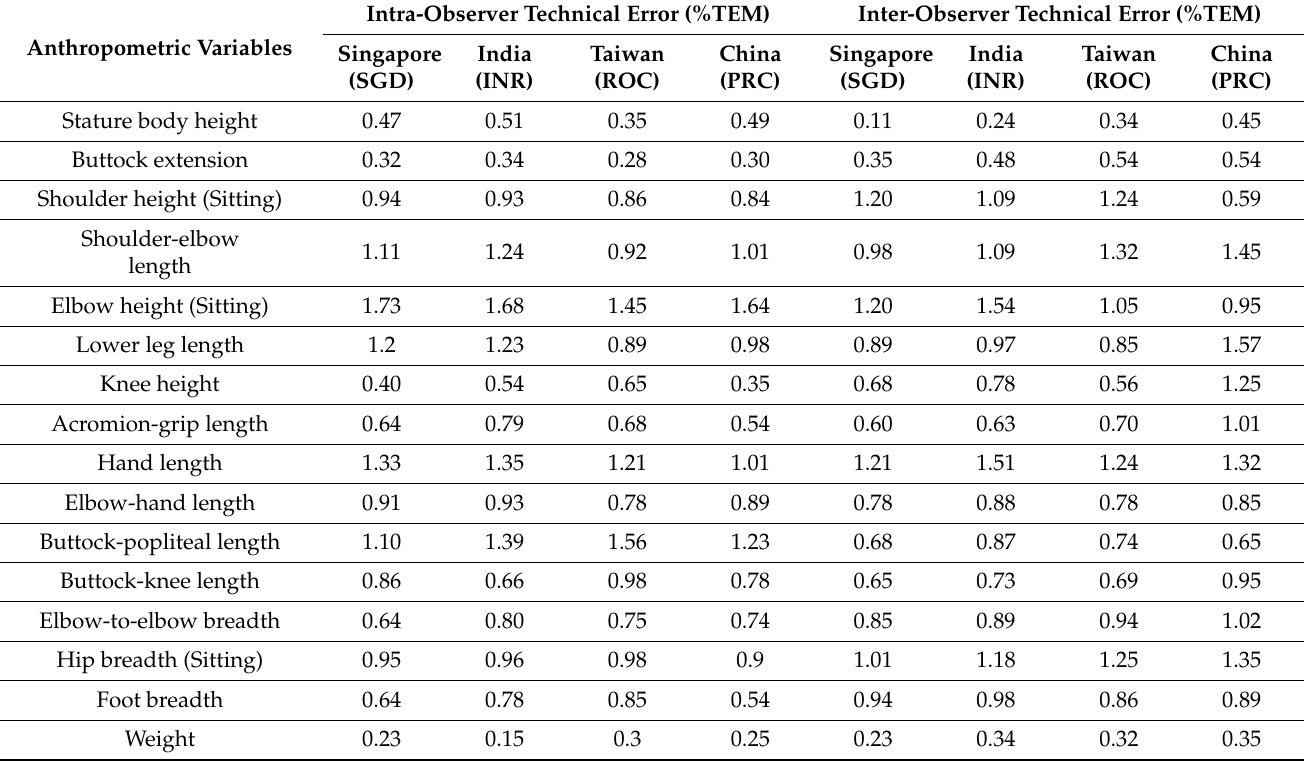
per Uth et al. [48]. Table A4. Technical Error of Measurement for 16 Anthropometrics ( n =